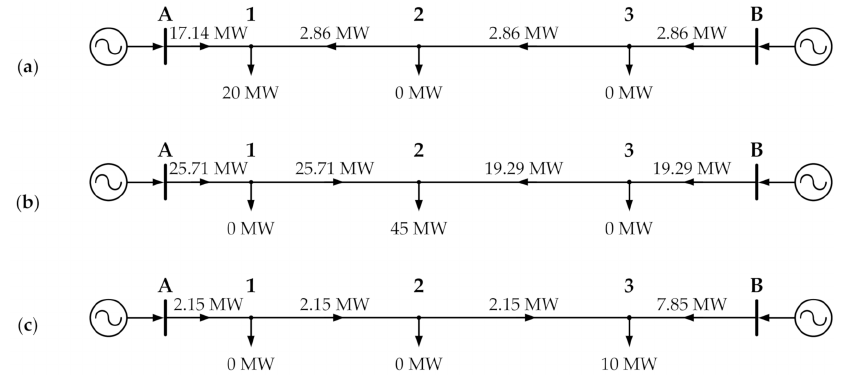
Figure 5. Decomposition of the base case power flow by the superposition principle–active power flows in the branches for the consumer in the bus: ( a ) 1; ( b ) 2; ( c ) 3.